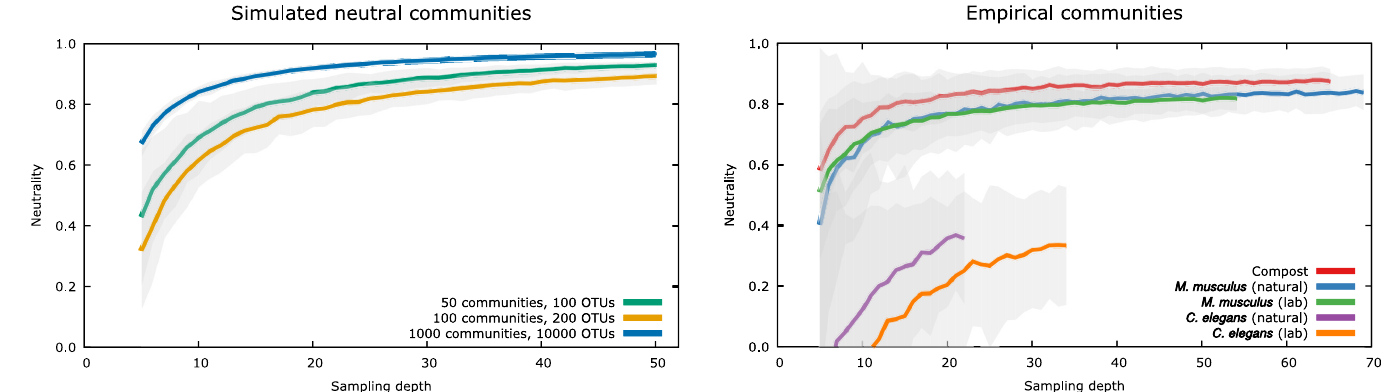
Fig 4. Impact of sample number on the goodness of fit of the neutral expectation. For each sampling depth, communities were resampled 100 times with replacement at a rarefaction level of 1,000 reads/sample. The left panel shows the results for simulated neutral communities. The immigration parameter was fixed at m = 0.05, and neutral dynamics were simulated for 10 6 time steps in all cases. Generally, goodness of fit remained high over a large range of sample sizes, reflecting the underlying completely neutral community dynamics. Note that the goodness of fit did not reach 1.0 in finite and relatively small metacommunities, even if all communities were sampled. The right panel shows the effect of subsampling for several host-associated microbial communities. As for the simulated data, observed levels of neutrality were relatively robust, only dropping off at very low sample sizes. The C . elegans datasets showed a very poor fit at very low sampling depths but began to level off well below the neutrality values of the other datasets. Shaded areas indicate 95% bootstrap confidence intervals. The data used to generate this figure are available in S1 Data. OTU, operational taxonomic unit.